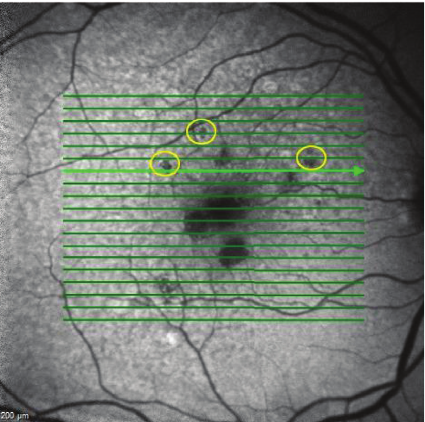
Figure 2: An example of retinal pigment epithelium atrophy by fundus autofluorescence. The yellow circle shows a region of ab- sence of